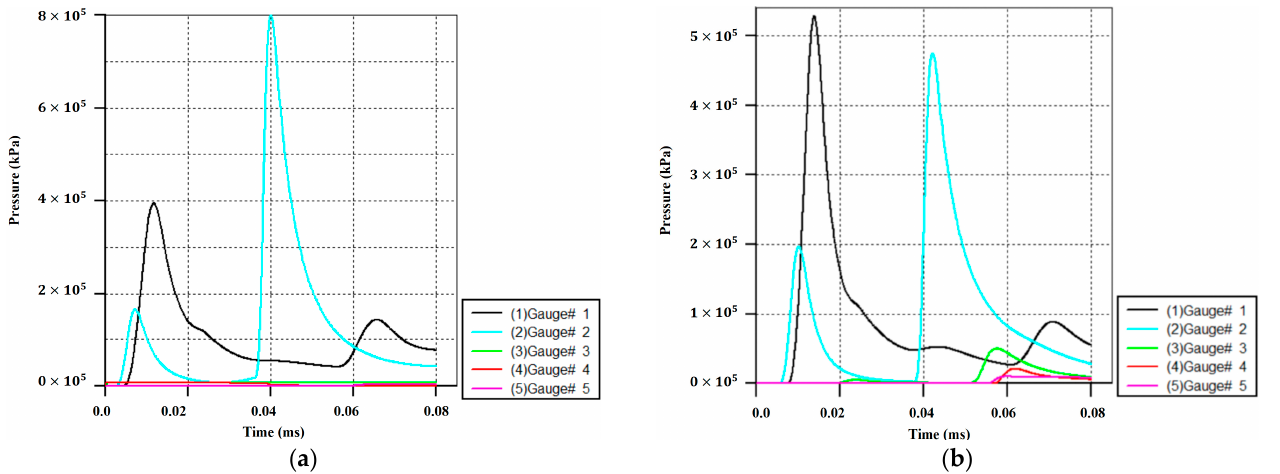
Figure 6. Pressure curves at each Gaussian point. ( a ) The pressure variation curve at each monitoring point, taking into consideration the influence of the arc; ( b ) The pressure variation curve at each monitoring point, without taking into consideration the influence of the arc.